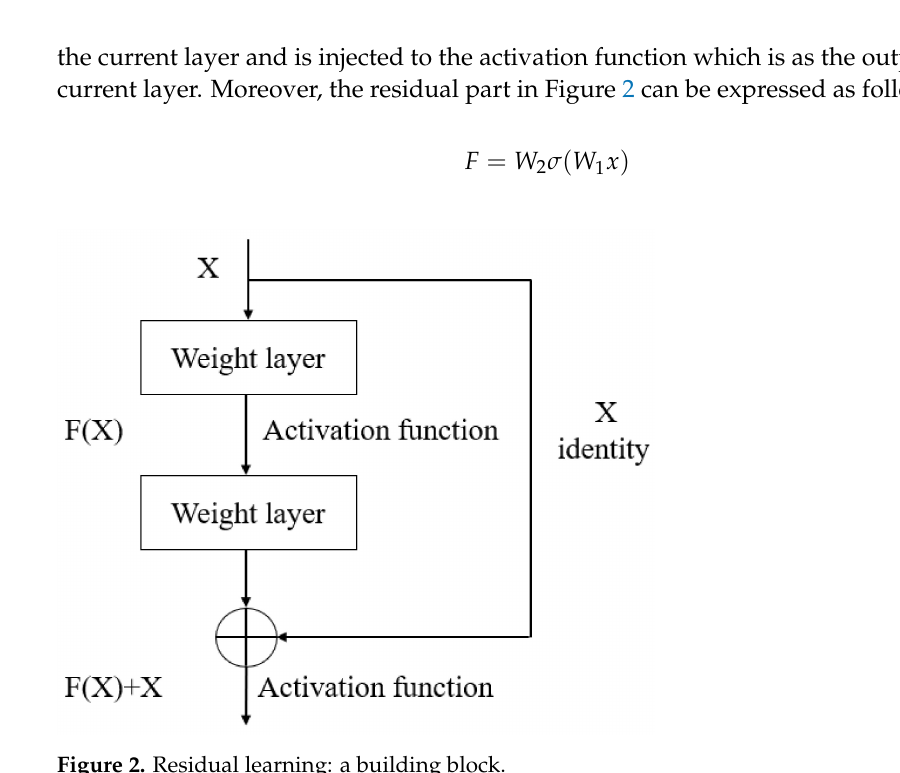
Figure 2. Residual learning: a building